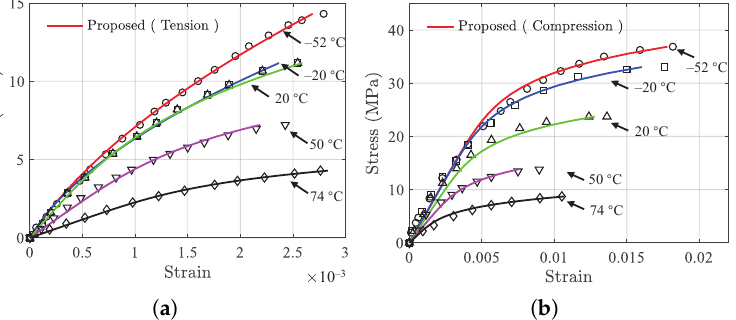
Figure 15. Validation results on third-party data in [28]. Solid lines are the model prediction results and discrete markers are testing data. ( a ) Tension, and ( b )